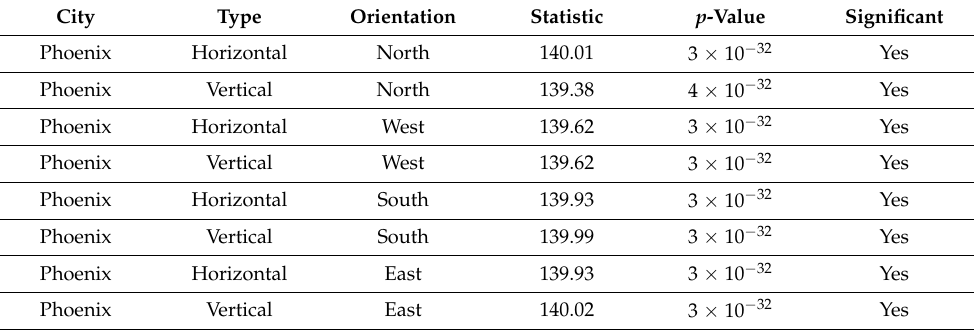
Table 13. Significant differences between positive and negative optimum adaptation angles in the city of